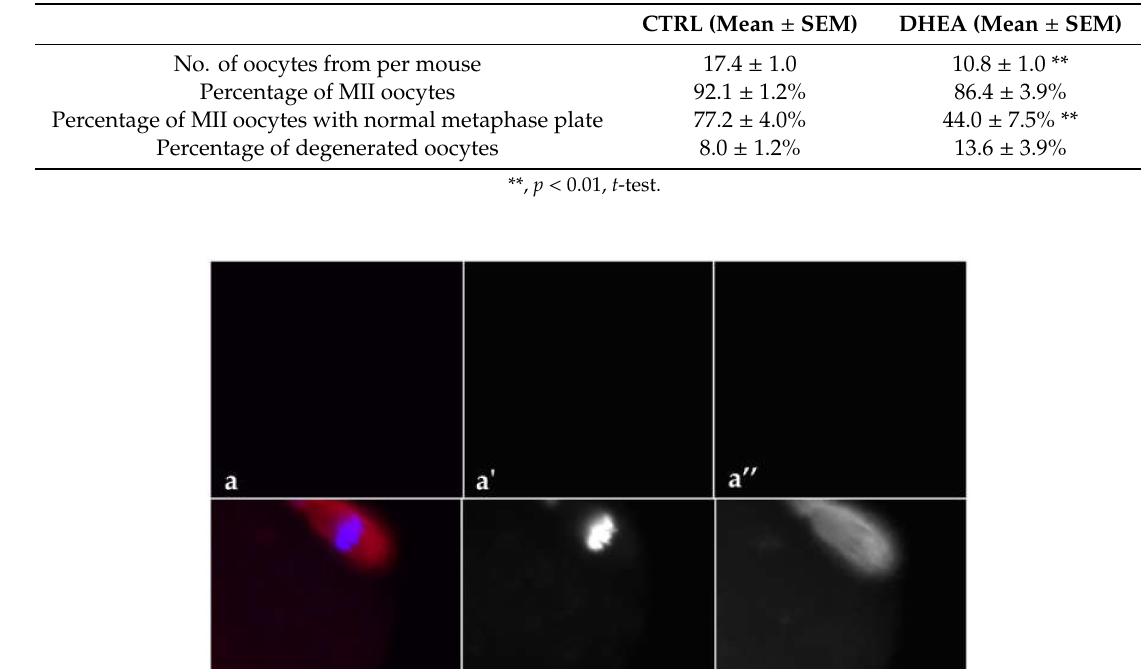
Table 1. E ff ect of DHEA on ovulatory function and oocyte quality.